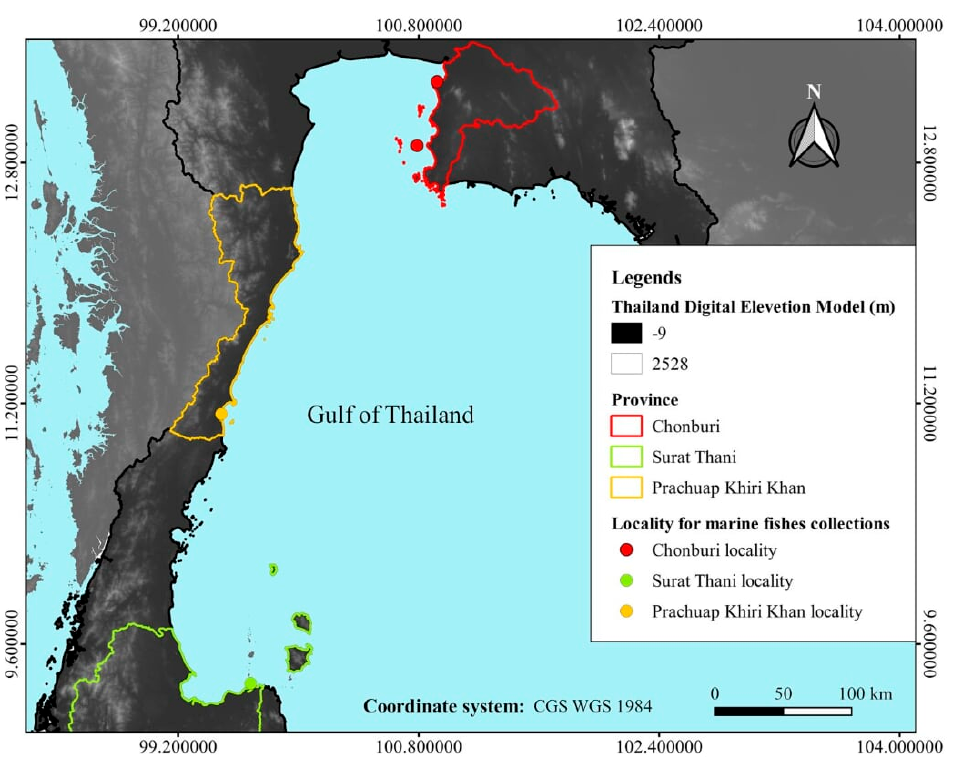
Figure 1. Map of study area in the Gulf of Thailand.